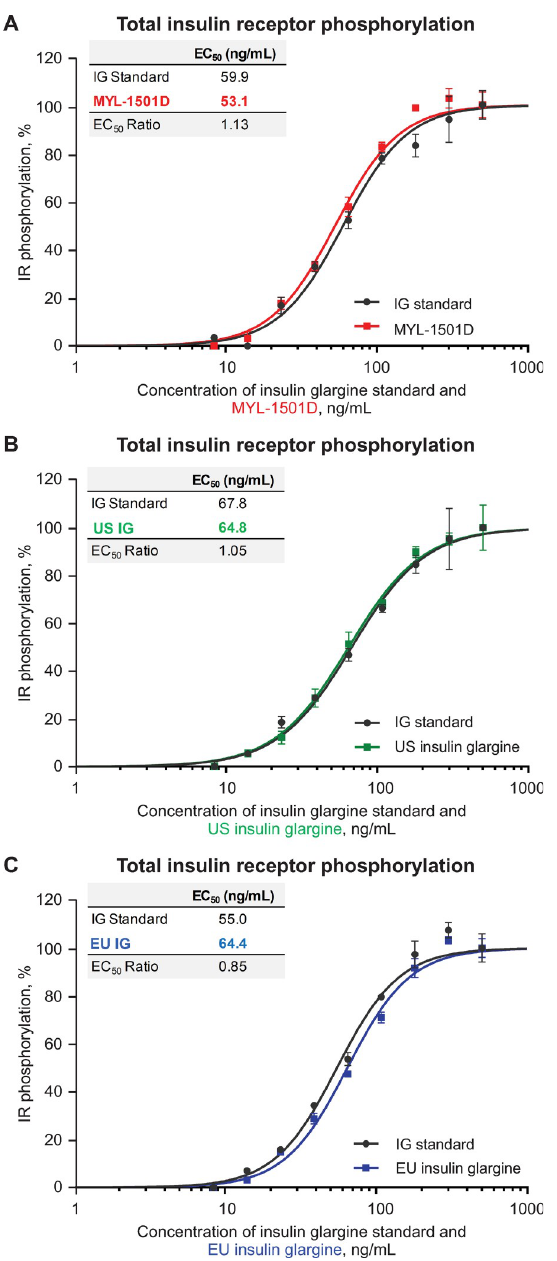
Fig 11. Representative dose-response curves of total insulin receptor phosphorylation assay in HepG2 cells. (A) MYL-1501D, (B) US-Licensed Insulin Glargine, and (C) EU-Licensed Insulin Glargine. All samples were analyzed against a common insulin glargine reference standard (IG standard) to normalize against day-to-day variability. Each lot was analyzed using 3 independent dilution preparations on an assay plate. Mean ± SEM for the % phosphorylation response is plotted (y-axis) against the concentration (x-axis). Four parameter logistic curve fit was applied to evaluate EC 50 . Each sample was analyzed on 3 independent assay plates, and average is reported. CHO, Chinese hamster ovary; EC 50 , half maximal effective